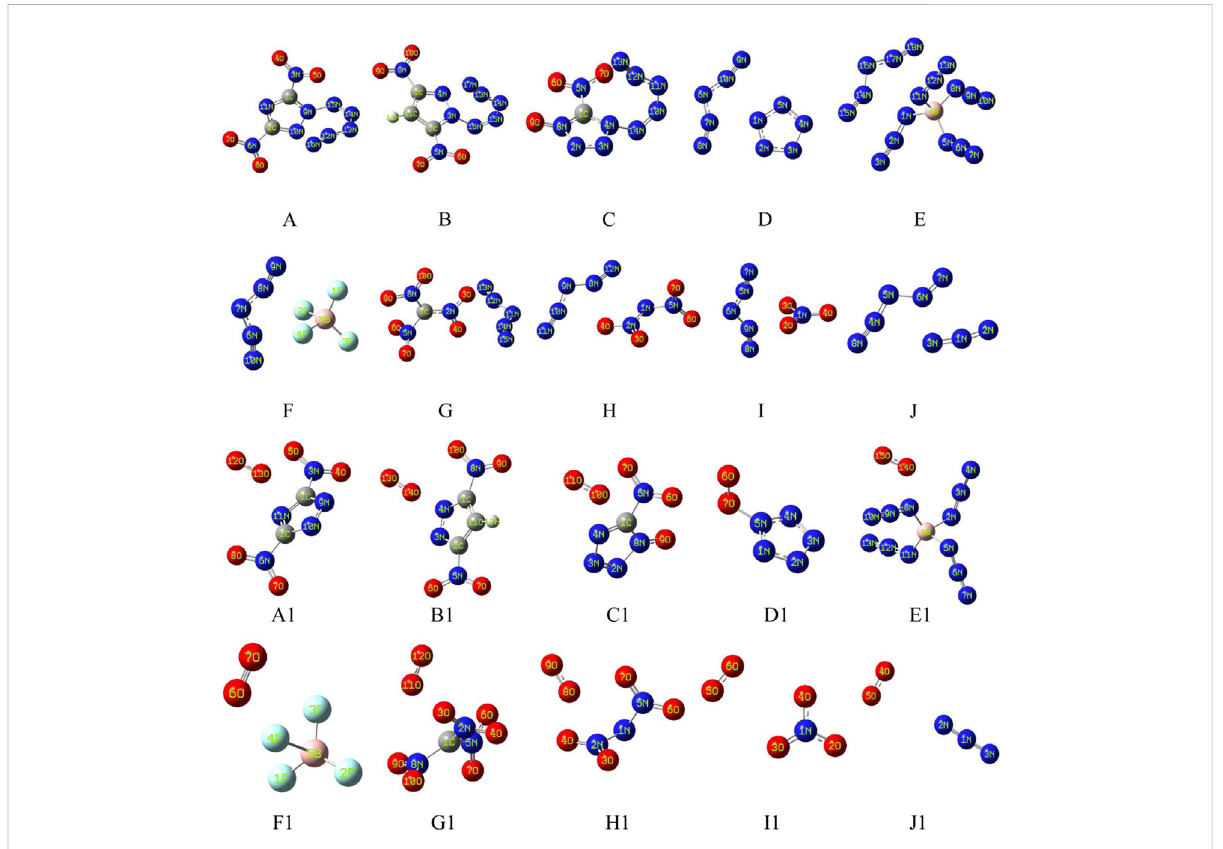
FIGURE 1 Theoretically designed energetic compounds containing N 5 + (A – J) and O 2 + (A1 – J1) ions at M06-2X/6-311+G (d, p) theory.